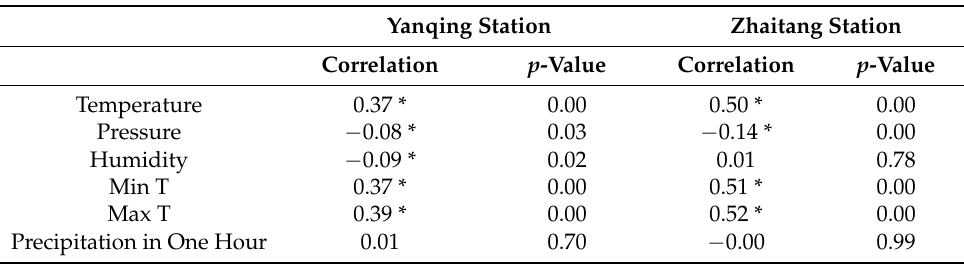
Table 4. Correlation of variables with wind speed (* indicates that the meteorological element is related to wind speed with a p -value of less than 5%). Yanqing Station Zhaitang Station Correlation p